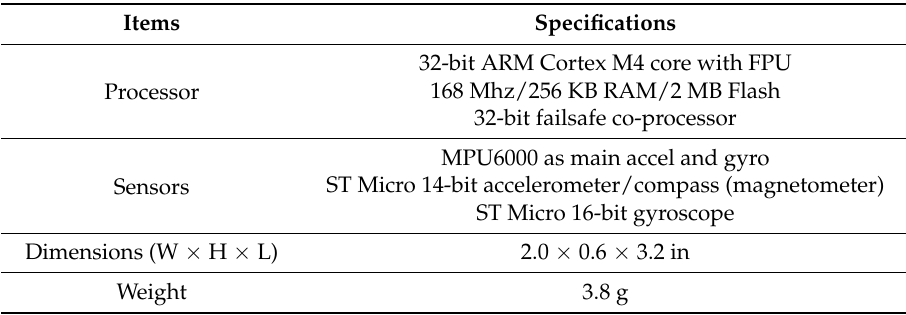
Table 4. Specifications of the Pixhawk controller for the fixed-wing UAV.